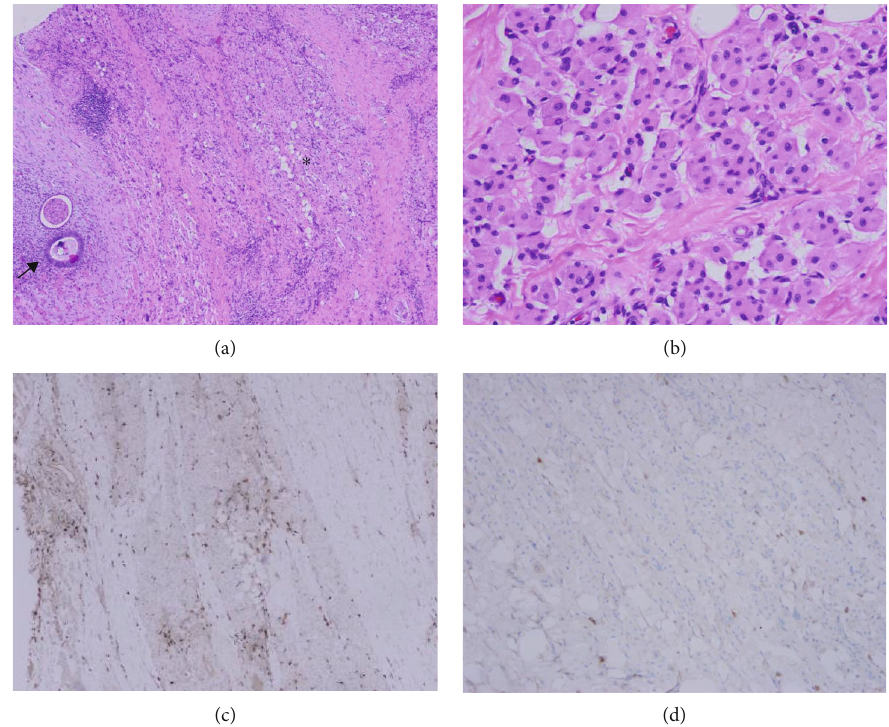
Figure 1: (a) Endometrial glands and stroma on the left (arrow) and multiple groups of small polygonal cells intervening the mass ( ∗ ) are demonstrated. (b) The cells are round to polygonal with distinct cell border and round single to multiple nuclei. (c, d) Those cells are negative with CD68 and Pax8 antibody,